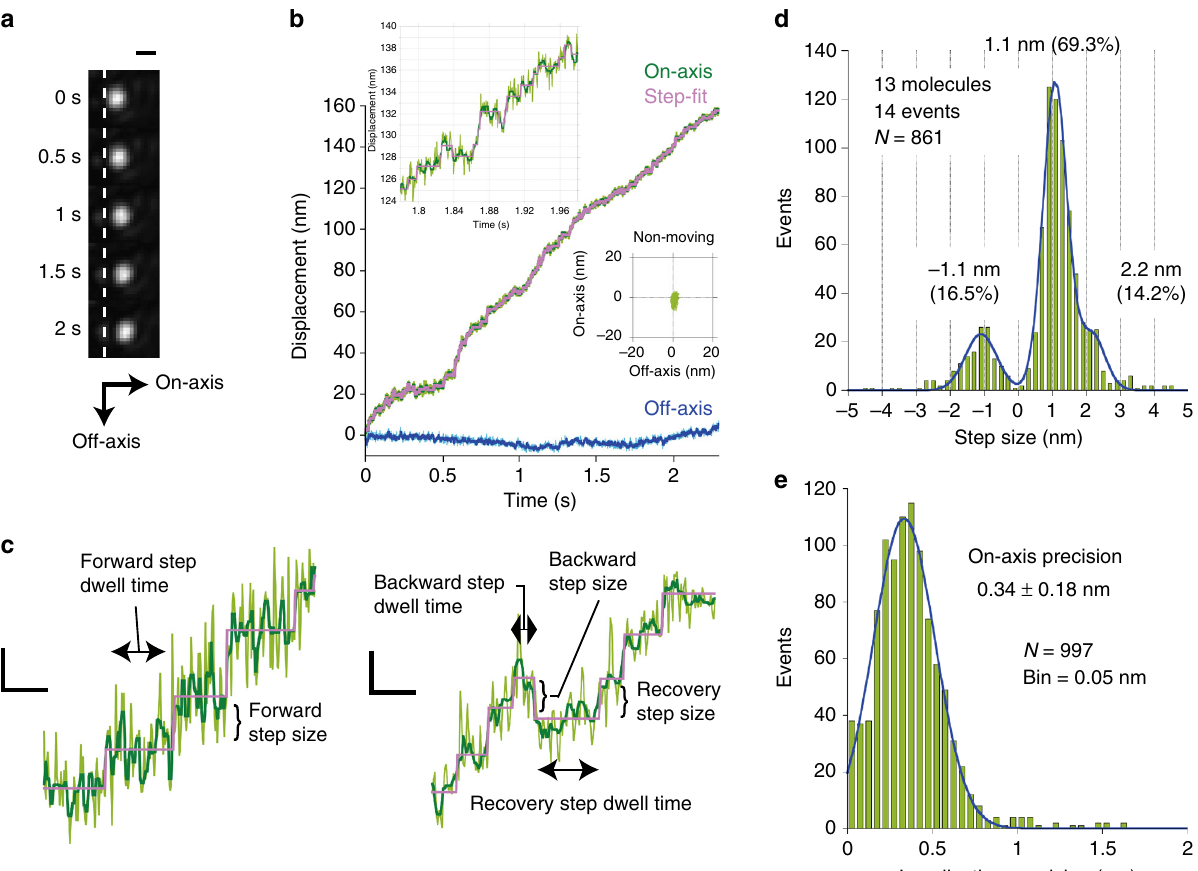
Fig. 2 Stepping movement of SmChiA probed by 40-nm AuNP. a Example of image sequence. Scale bar is 400 nm. b Trajectory of SmChiA movement shown in a . Raw trajectory: light green; median- fi ltered (current ± 2 ms): dark green. Magenta line: steps and pauses fi tted to median- fi ltered trajectory. Two-dimensional trajectory of non-moving molecule in the same fi eld of view is also shown, in the same scale. c Examples of expanded trace. Forward, backward, and recovery step sizes and dwell times before these steps are indicated. Scale bars on vertical and horizonal axes are 1 nm and 30 ms, respectively. d Forward and backward-step size distribution. The peak values of Gaussian fi ttings (blue line) are shown. Step ratios were estimated from Gaussian areas. e On-axis localisation precision during pauses. The value is peak ± SD of Gaussian fi tting (blue